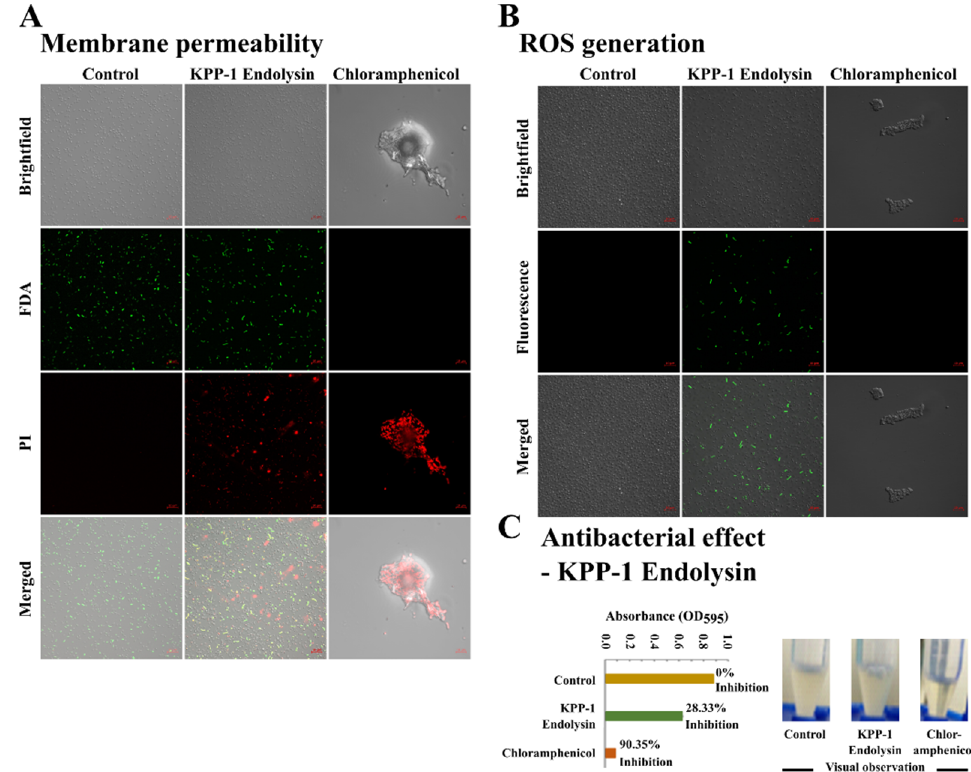
Figure 8. Assessment of membrane permeability, oxidative stress, and lytic ability of KPP-1 endolysin. ( A ) KPP-1 endolysin-induced membrane permeability of K. variicola was assessed using PI